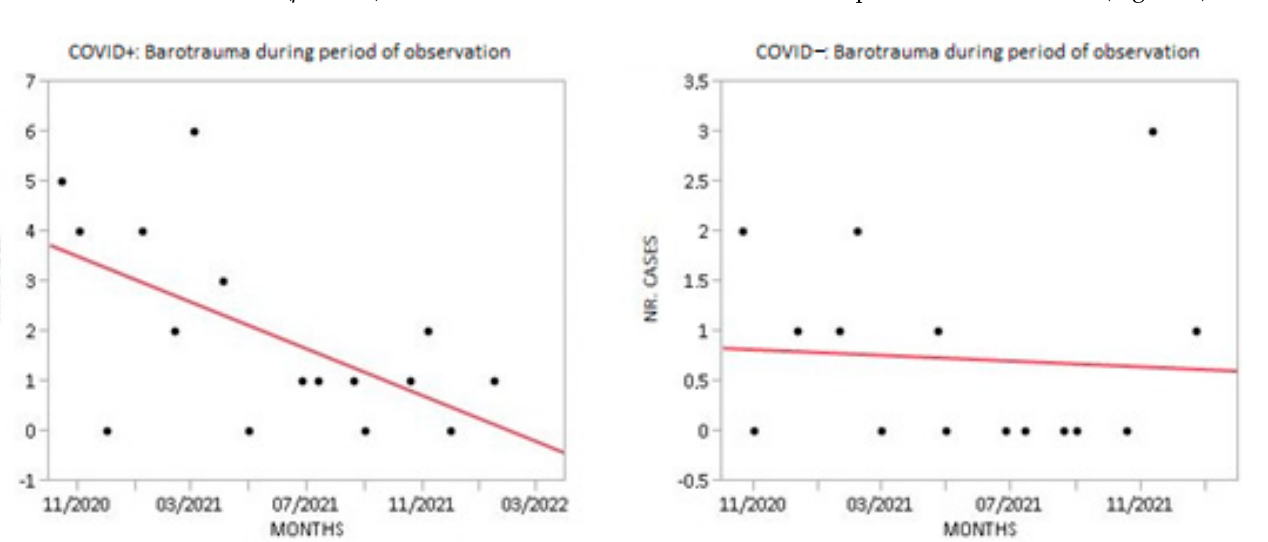
Figure 8. Cases of barotrauma in COVID+ group vs. COVD- group during period of observation.